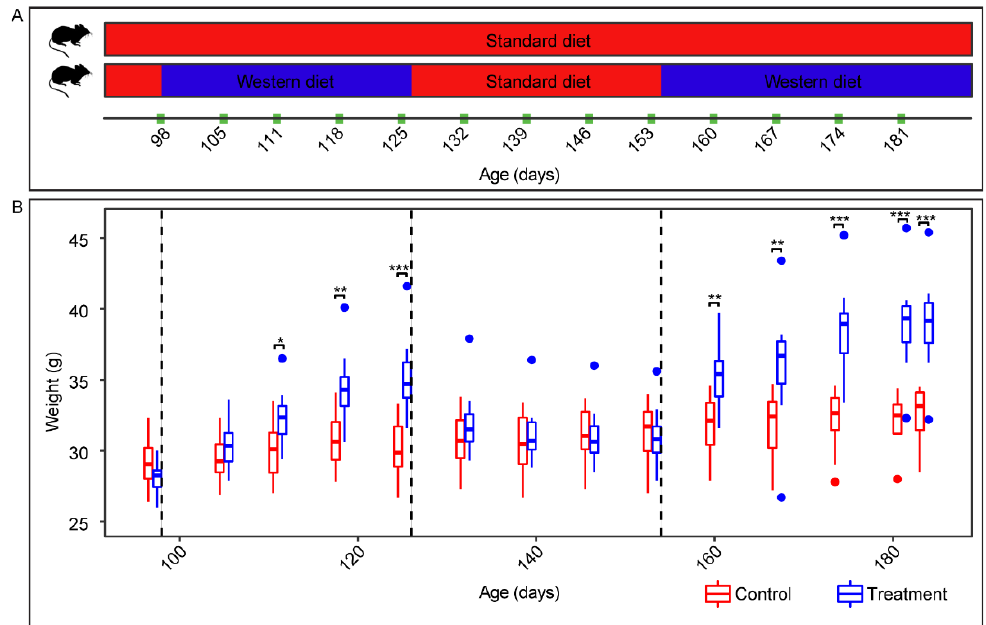
Figure 1. Experimental treatment and bodyweight over time. ( A ) Experimental timeline showing dietary regimens and timepoints for body weight measurements. ( B ) Boxplot depicts the weight of mice over time. Wilcoxon rank sum test was carried out to compare the weight between WD- and SD-mice ( n = 12 mice per group). Asterisks represent significant difference where (*) denotes q < 0.05, (**) denotes q < 0.01 and (***) denotes q < 0.001. Dotted lines indicate a switch in diet for the treatment group.